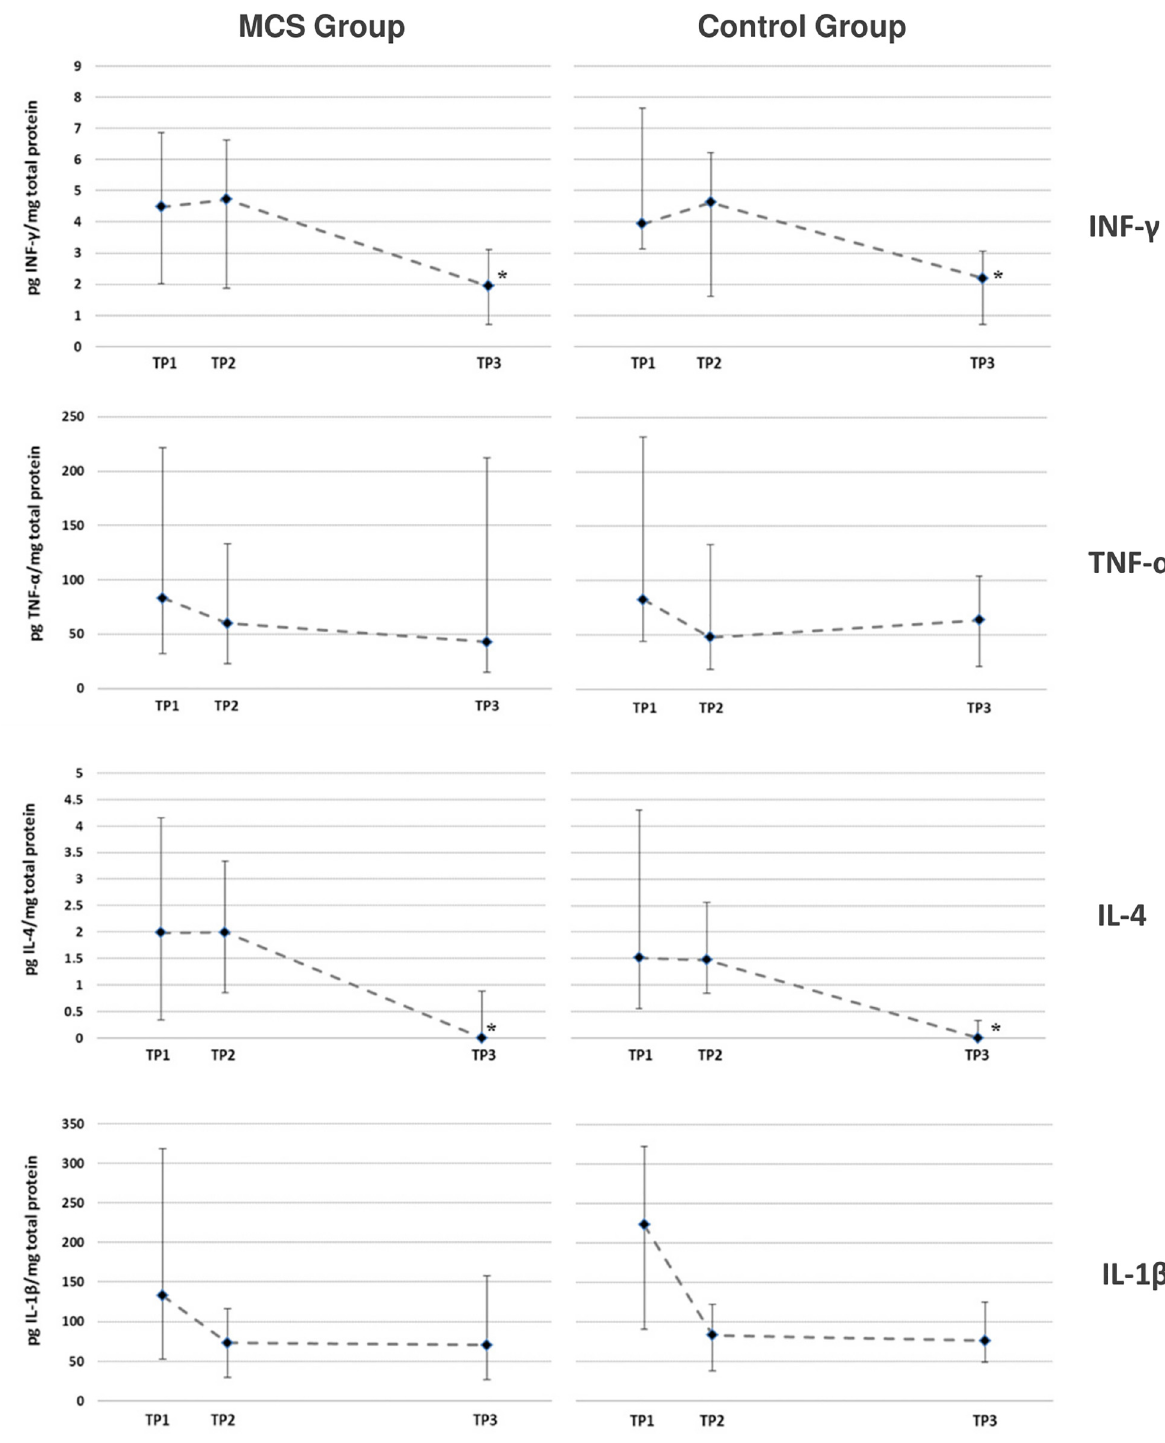
Fig 3. n -butanol exposure and upper airway inflammatory mediators. Data are shown as median level with interquartile range of interferon- γ (IFN- γ ), tumor necrosis factor- α (TNF- α ), Interleukin-4 (IL-4) and IL-1 β (in pg analyte/mg total protein) measured in the upper airway epithelial lining fluid from the MCS group and from the control group at the three time points (TP); TP1 at time zero, TP2 at the end of the n -butanol exposure and TP3 4 hours post exposure. Asterisks refer to significant differences (P (cid:1) 0.05) in analyte concentrations between TP1, TP2 and TP3 within either the MCS or the control